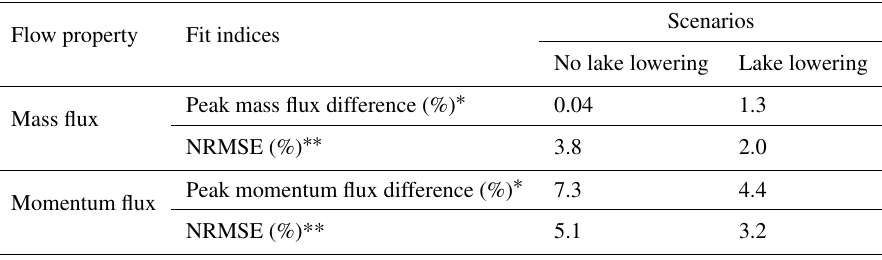
Table 5. Fit indices for flow properties at the overtopping zone of Lake Palcacocha (target cross section in Fig. 5) comparing BASEMENT and FLOW3D simulation results.